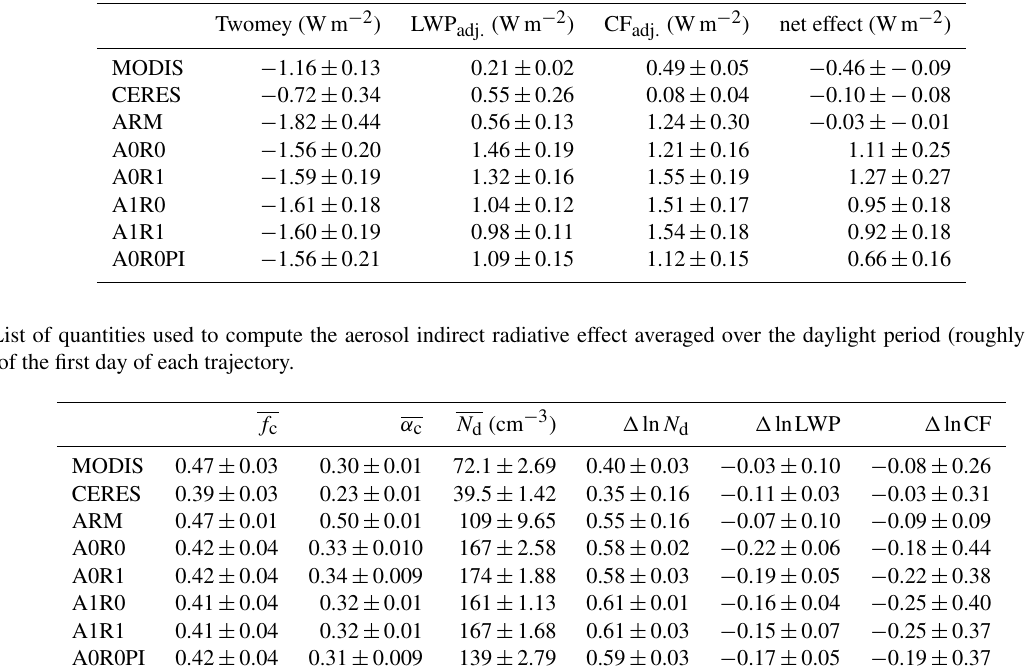
Table 4. List of radiative effects decomposed into contributions from the Twomey effect and liquid water path and cloud fraction adjustments averaged over the daylight period (roughly from 09:00 to 15:00LT) of the first day of each trajectory.